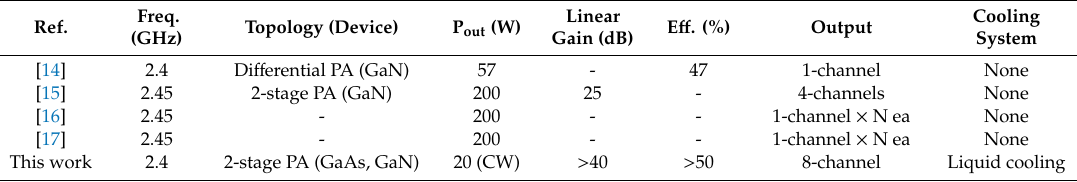
Table 3. Comparison with RF source module with solid-state power amplifiers for plasma generators. Freq. Ref.